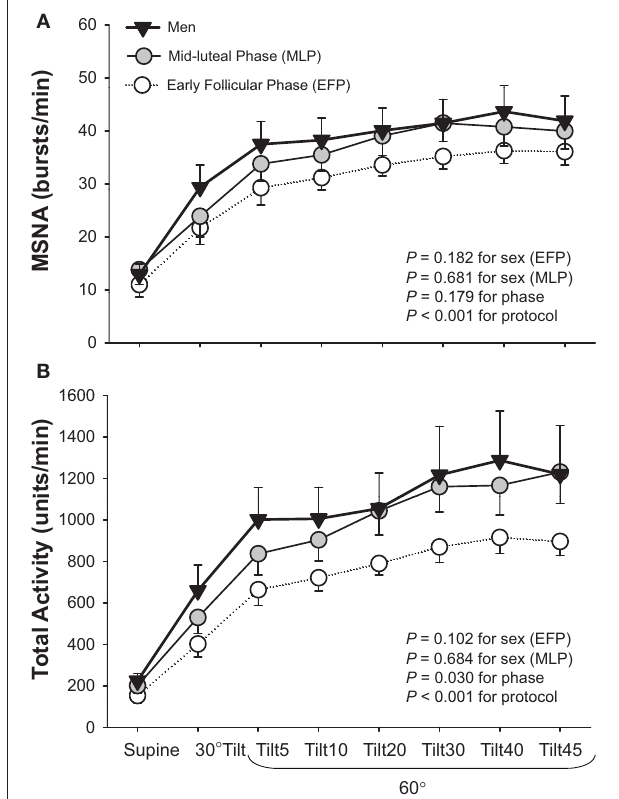
FIGURE 2 | Muscle sympathetic nerve activity (MSNA) burst frequency (A) and total activity (B) responses during a graded upright tilt in men and women during the early follicular phase (when both estrogen and progesterone are low) and the mid-luteal phase (when both sex hormones are high). Values are means ± S.E.M. Tilt5, Tilt10, Tilt20, Tilt30, Tilt40, and Tilt45, 5, 10, 20, 30, 40, and 45min after 60 ◦ upright tilt. Adapted with permission from Fu et al.